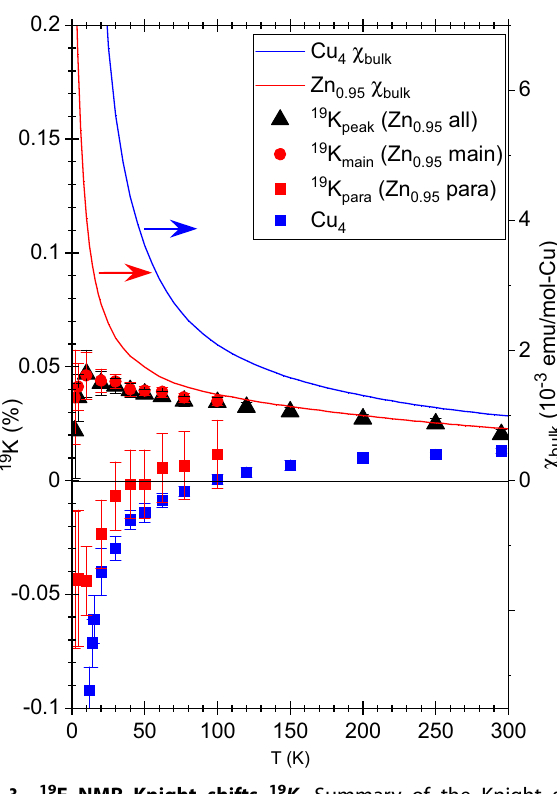
Fig. 3 19 F NMR Knight shifts 19 K . Summary of the Knight shift measured in B ext = 2.4 T for Zn 0.95 : 19 K peak as determined at the nominal peak frequency 19 f peak of the overall lineshape ( ▴ ), 19 K main ( ) and 19 K para ( ) for the main and paramagnetic side peaks as determined from the deconvolution of C ( f ; 1/ T 1 ) based on double Gaussian fi t. For comparison, we show 19 K measured for the single peak observed for antiferromagnetic Cu 4 ( ). The vertical error bars specify the maximum possible range of uncertainties. Using the right axis, we also show the bulk magnetization data of χ bulk measured in 2.4 T for Zn 0.95 (red) and Cu 4